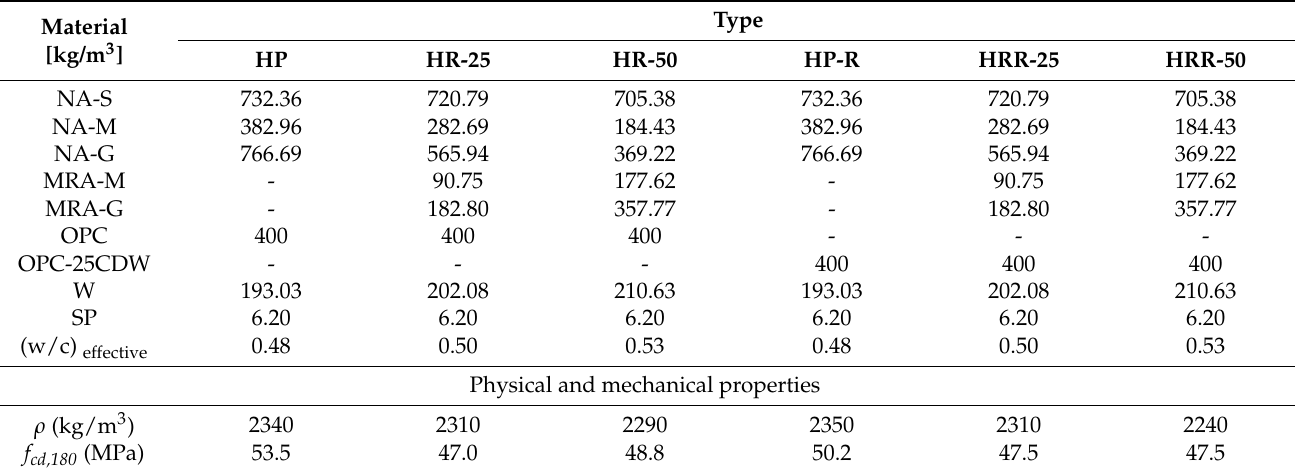
Table 6. Concrete mix proportions.